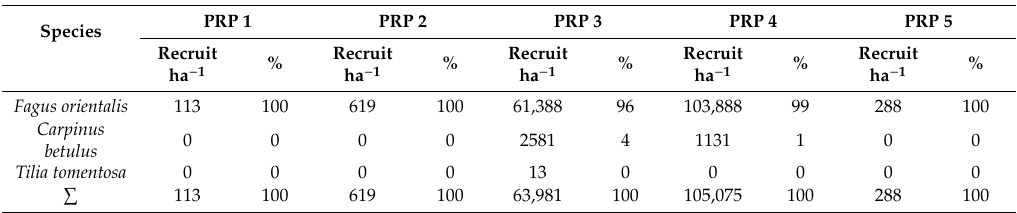
Table 6. Representation of recruits per hectare and in percentage according to tree species on permanent research plots